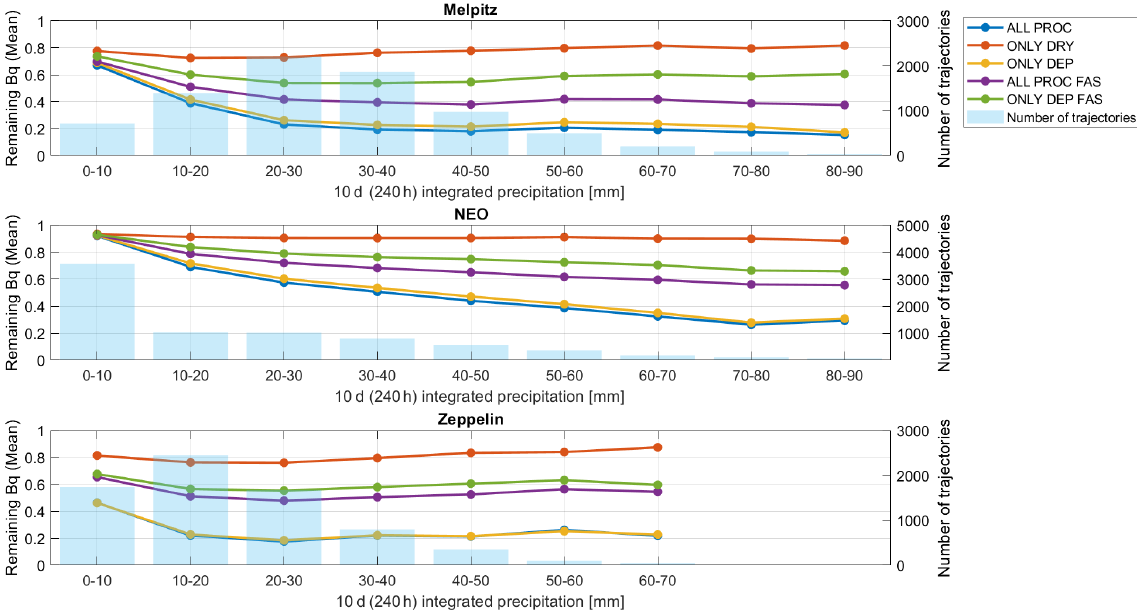
Figure 7. Total accumulated precipitation and caesium concentration at the end of the 10d trajectories. The trajectories are binned with respect to its total accumulated precipitation ( x axis). The mean final caesium concentration for all trajectories in each bin is plotted (left- hand y axis). The unit is normalized Becquerel values for each of the experiments. The number of trajectories in each bin is shown in blue bars (right-hand y